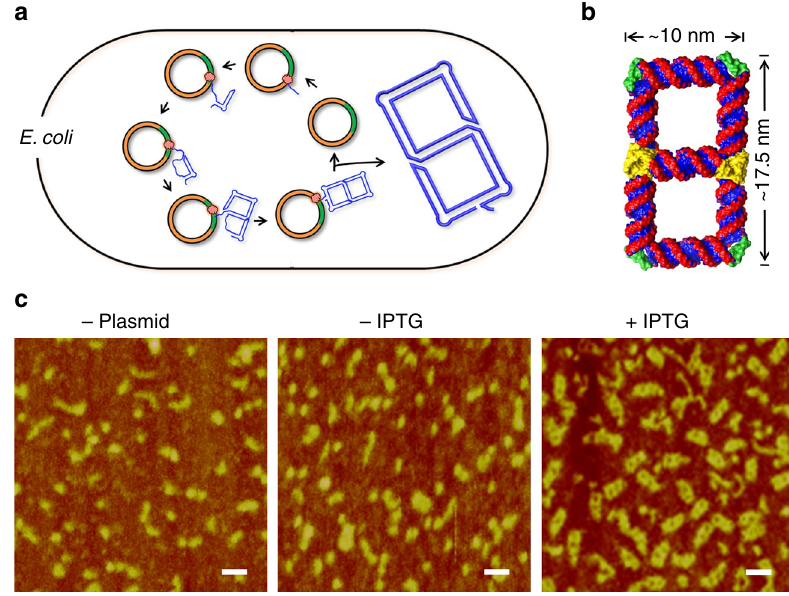
Fig. 5 Cloning and in vivo expression of RNA nanostructures. a Overall scheme. An expression vector (pET23a, orange) carrying an S2 -coding DNA sequence (green) is transformed into E. coli cells. Upon IPTG induction, the S2 gene gets transcribed into RNAs, which self-fold into the designed double- square structure in the cell. b Structural model of the S2 structure. c AFM imaging of cell lysates from E. coli without the expression vector (- Plasmid), or with the vector but without S2 gene expression induction (- IPTG), or with S2 gene expression ( + IPTG). (Scale bar: 20